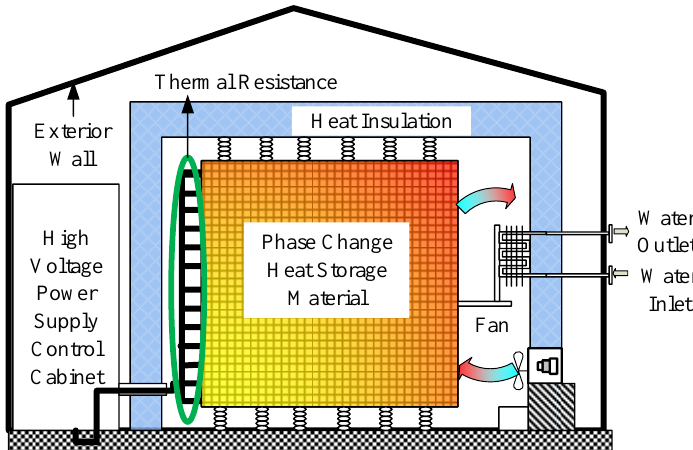
Figure 3. Schematic diagram of TES using phase change